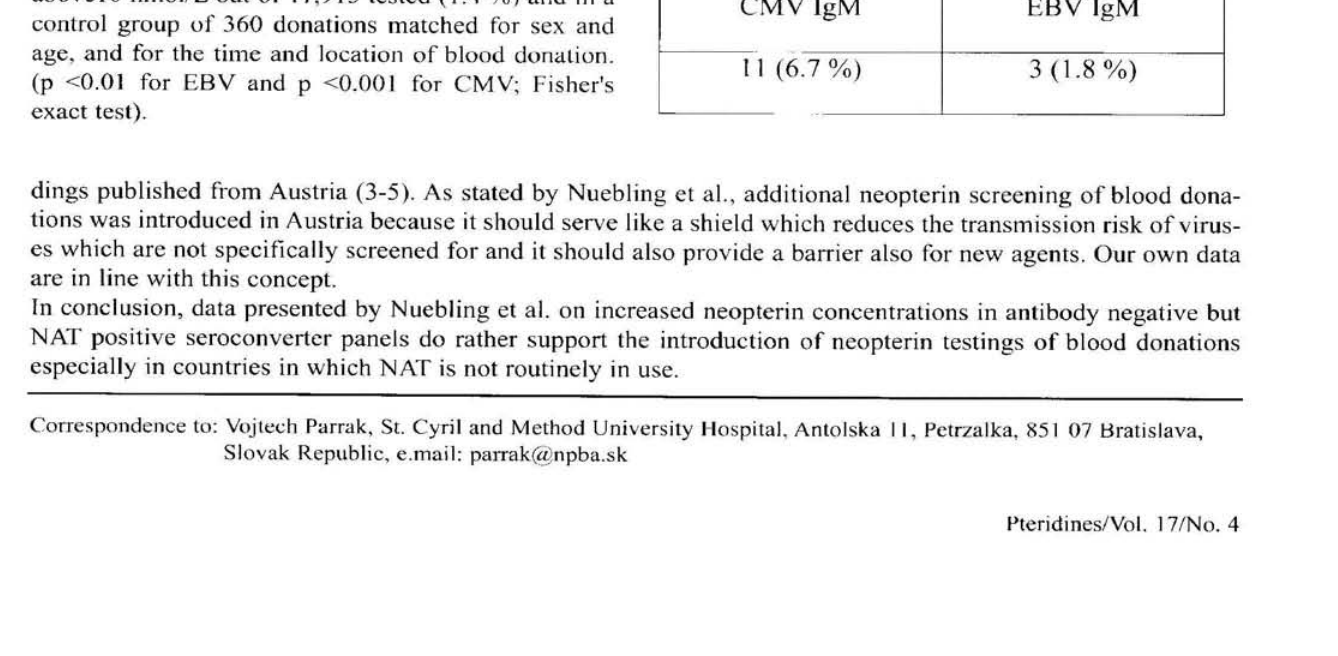
Table 1: CMV and EBV IgM seropositivity in 165 blood donations with neopterin concentrations above 10 nmol/L out of 11,915 tested (1.4 %) and in a control group of 360 donations matched for sex and age, and for the time and location of blood